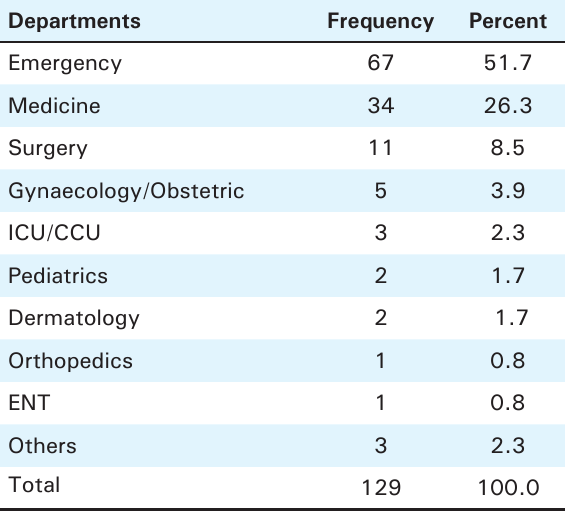
Figure1. Age distribution Figure 2: Methods of self Table 2. Referring departments in order of frequency